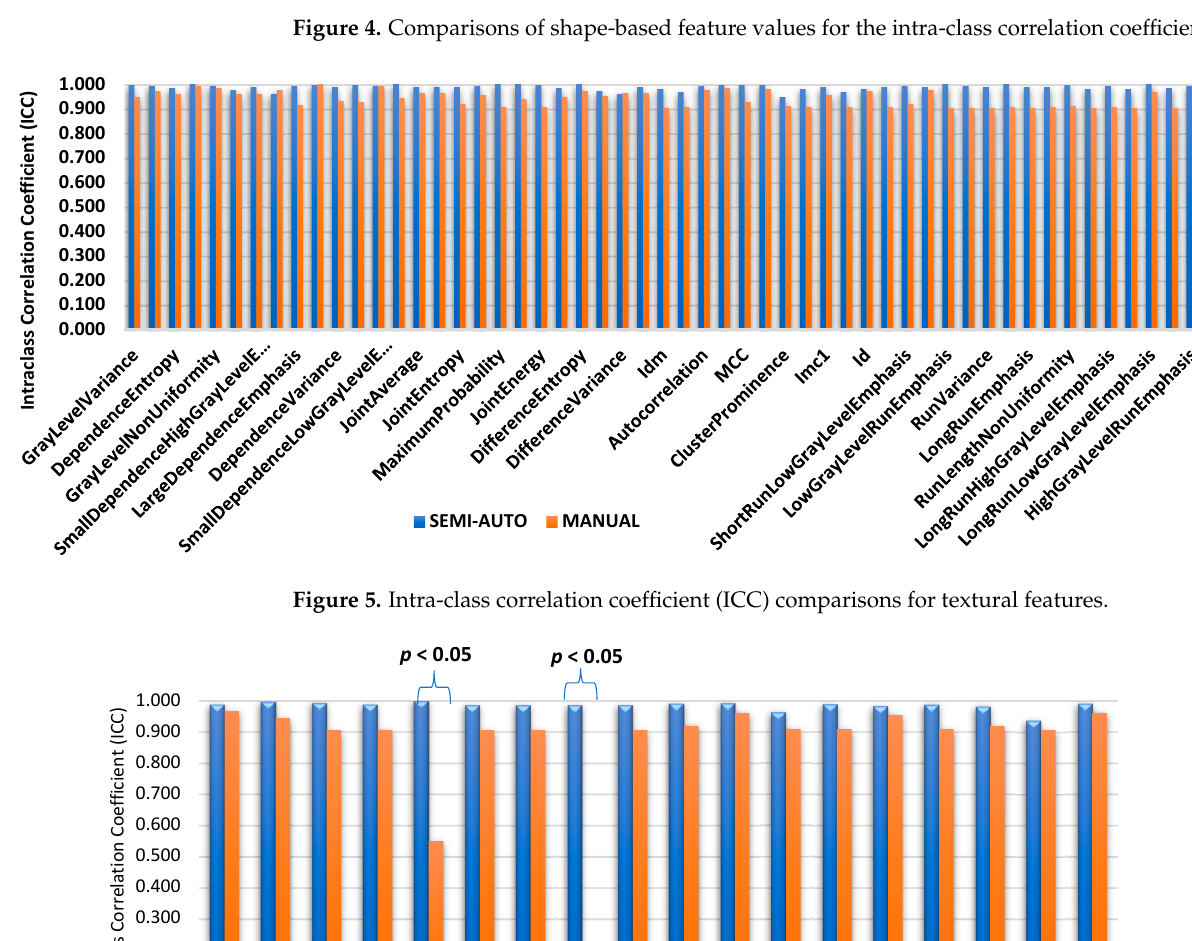
Figure 7. Correlation heatmap between observers. According to ICC values, extracted features are categorized into three: high repro- ducibility (ICC ≥ 0.8); medium reproducibility (0.8 ≥ ICC ≥ 0.5); and low reproducibility (ICC < 0.5). Based on 86 features, manual segmentation had 97.67% high, 1.16% medium, and 1.6% low reproducibility. The flood filling effect, which is a result of semi-automatic segmentation, has 100% features in high reproducibility. Table 2 present features derived from reproducibility groups in both segmentations. As a result, Semi-automatic segmen- tations had better repeatability of the derived characteristics.